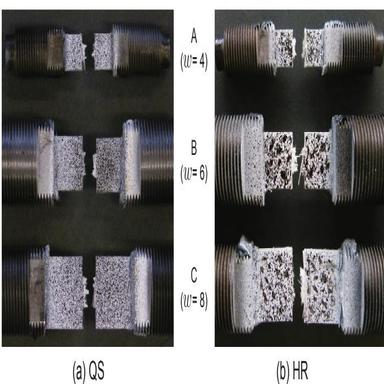
Failed GFRP DENT specimens after QS and HR loadings.